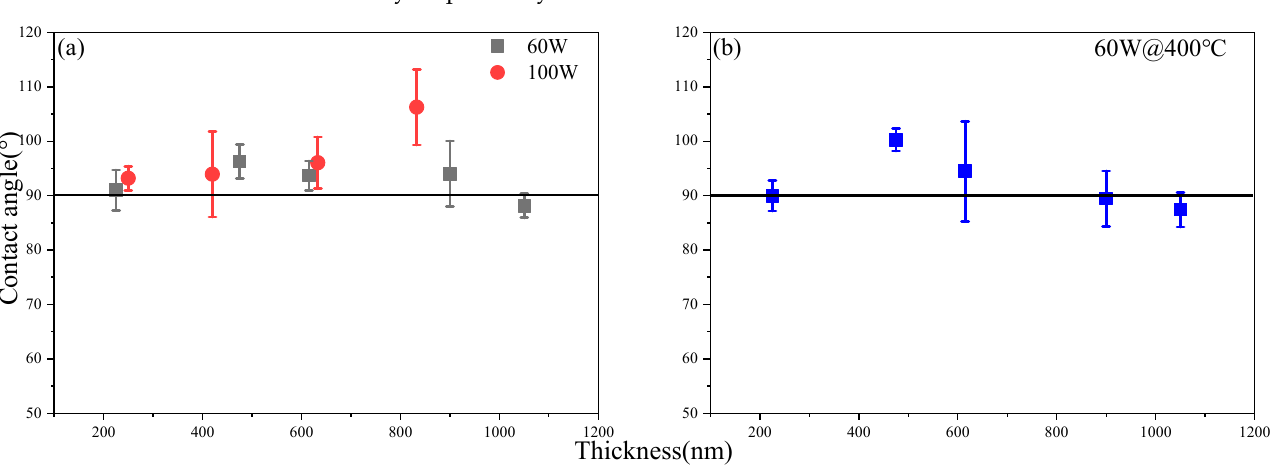
Figure 7. The water contact angles of Y 2 O 3 films for ( a ) as-deposited samples 1-1 to 1-4 and 2-1 to 2-5, and ( b ) samples 2-1 to 2-5 after annealing at 400 °C.